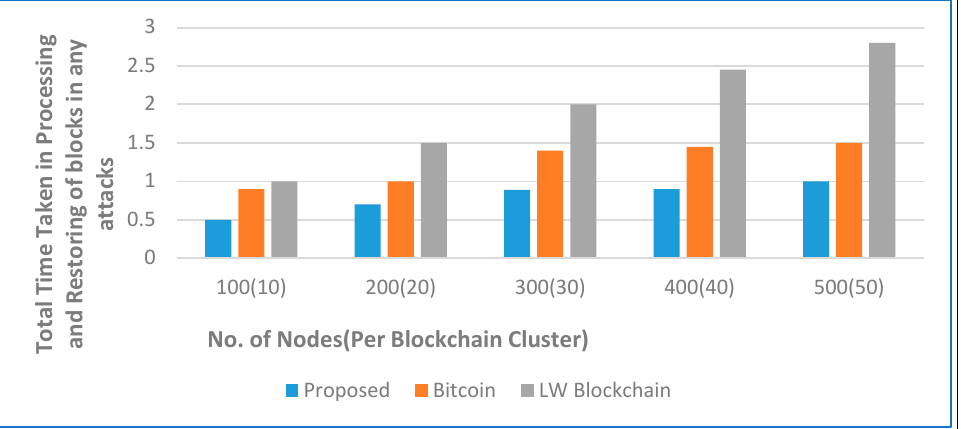
Figure 7. Total processing time and restoring time of blocks against the increase in the number of nodes.